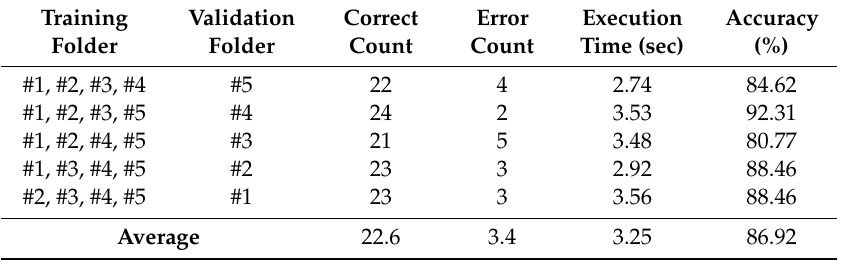
Table 4. k -fold cross-validation for the approach of ANN with the convolutional